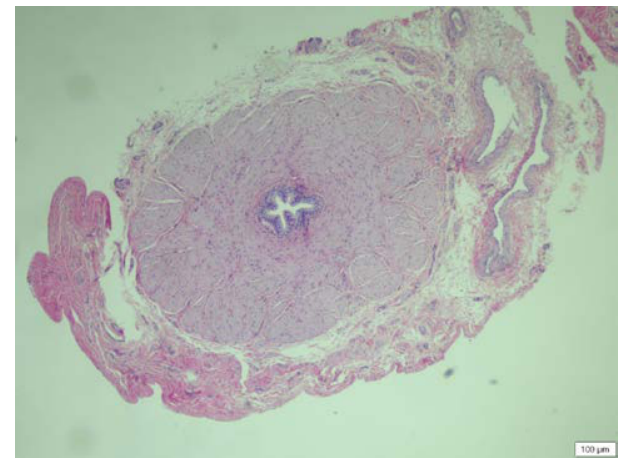
Figure 3: A central lumen that sometimes contains spermatozoa, lined by ciliated pseudo-stratified columnar epithelial cells, supported by a thin ring of connective tissue; The epithelial cells and supporting lamina propria are arranged in folds; The mucosal layer is circumferentially bordered by three layers of smooth muscles, namely the inner and outer longitudinal muscular layers separated by a middle circular muscular layer; The outer longitudinal muscular layer is surrounded by an admixture of adipose and loose fibrous connective tissue interspersed with arteries, veins and bundles of skeletal muscle (cremaster